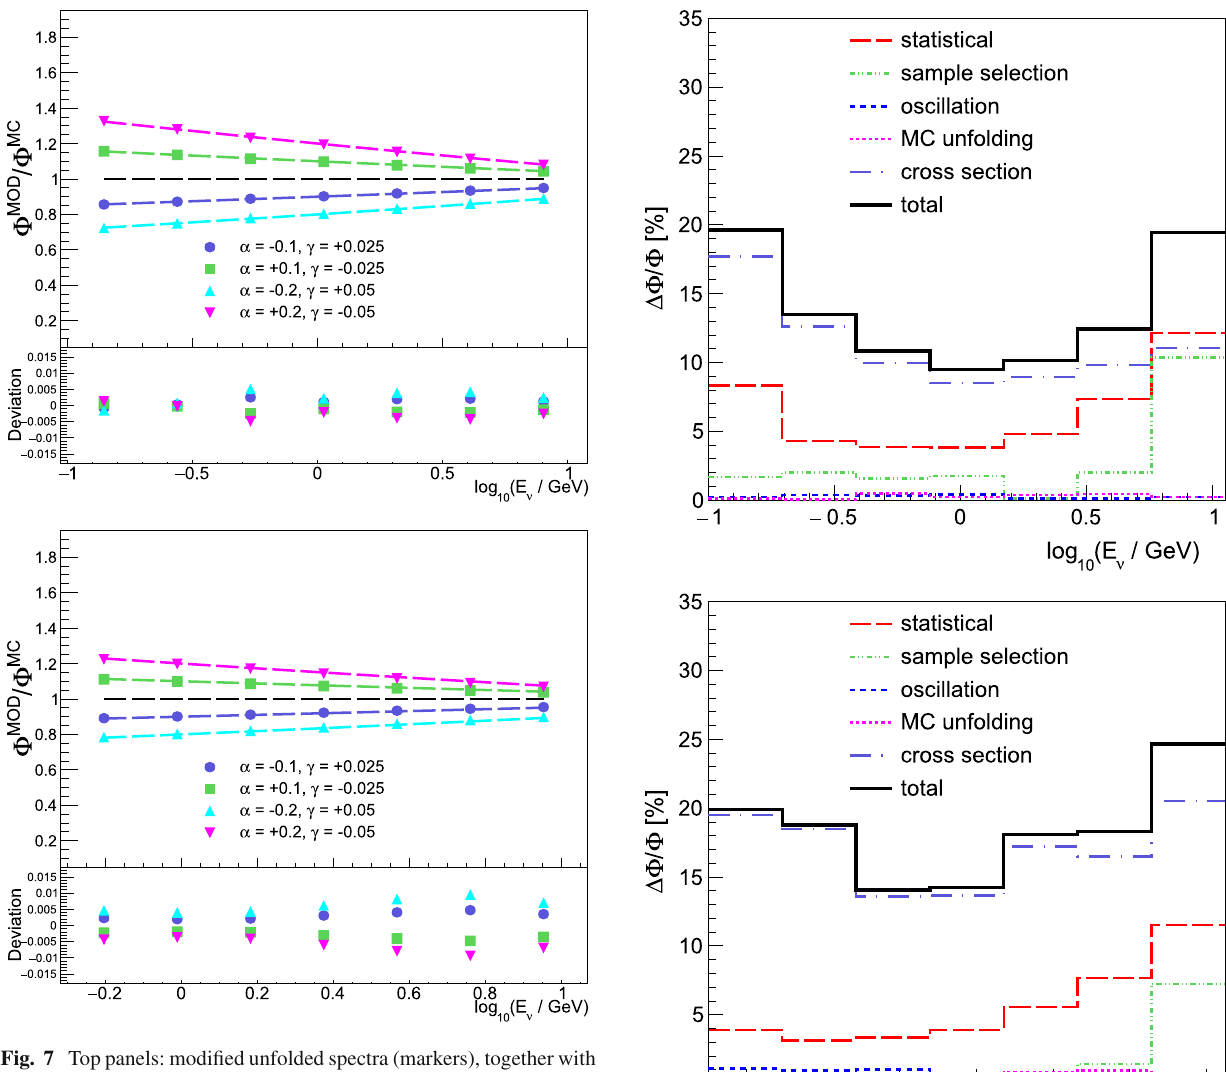
Fig. 7 Top panels: modified unfolded spectra (markers), together with the corresponding input (dashed lines). Bottom panels: relative devia- tion. Top: ν e spectra; bottom: ν μ spectra. Φ MC represents the nominal flux model [33], which is reported as the black dashed line. Four sets of modified spectra are plotted, whose α and γ values are reported in the figures Table 3 Relative deviations of the conditional probabilities evaluated by using the ν e sample log 10 (NPE) log 10 ( E ν / GeV) − 1 to − 0.5 − 0.5 to 0.36